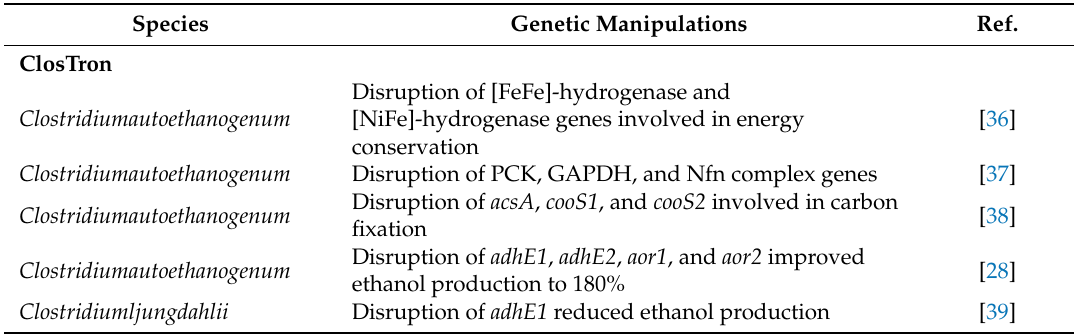
Table 2. Genome engineering tools used in